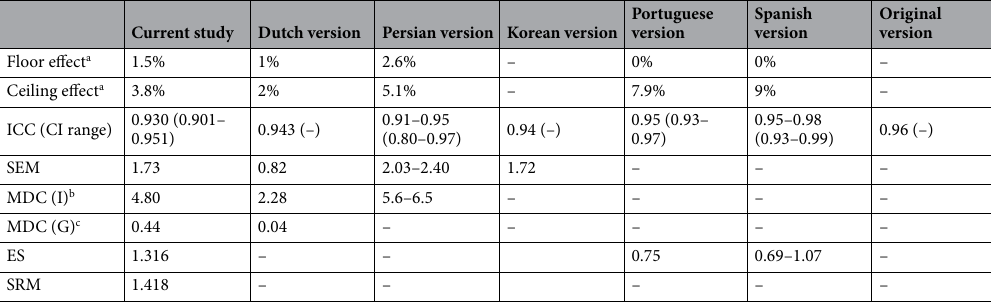
Table 3. The floor/ceiling effects, test–retest reliability, measurement error and responsiveness of CAIT-C. CAIT-C Chinese version of Cumberland Ankle Instability Tool, ICC intraclass correlation coefficient, CI confidence interval, SEM standard error of measurement, MDC minimal detectable change, ES effect size, SRM standardized response mean. a Percentage of patients with the worst (floor effect) and the best (ceiling effect) score. b The MDC value at an individual level. c The MDC value at the group level.